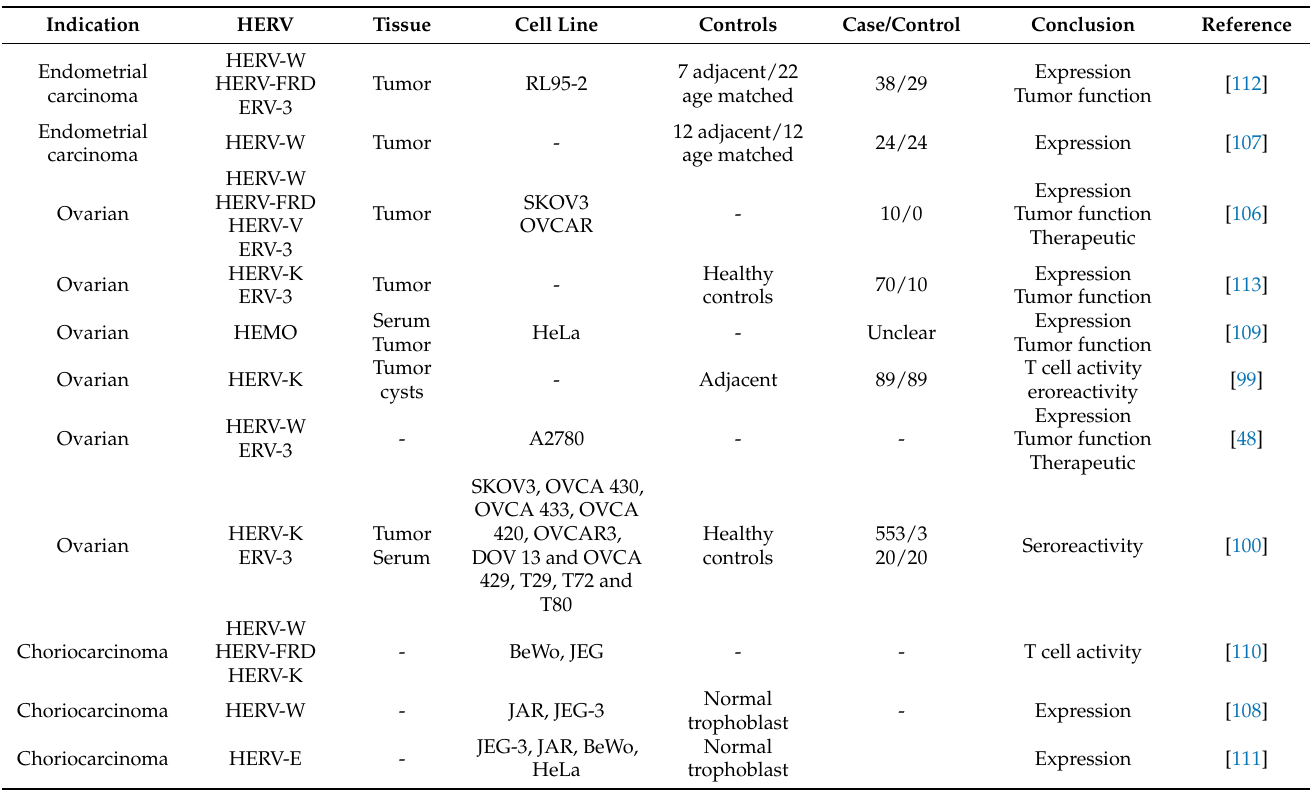
Table 8. HERV protein expression in gynecological